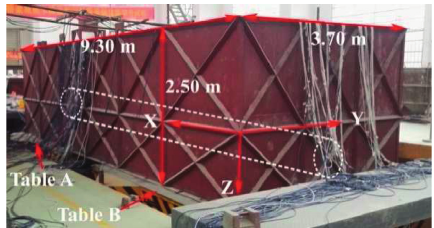
Figure 9: Outside of the model box.